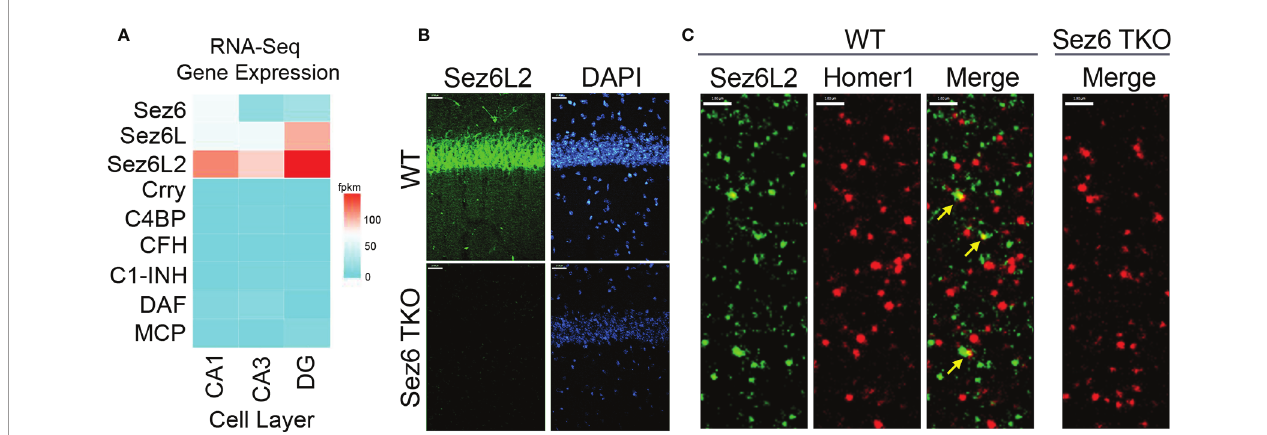
FIGURE 1 | Sez6 family expression in the hippocampus. (A) Sez6, Sez6L, and Sez6L2 are expressed by principal (excitatory, pyramidal) neurons of the mouse hippocampus at much higher levels than other known complement regulators (namely Crry, C4BP, CFH, C1-INH, DAF, and MCP). Expression data was obtained from Hipposeq: a comprehensive RNA-Seq database of gene expression in hippocampal principal neurons [http://hipposeq.janelia.org (60)]. The RNA samples used in this database were isolated from mouse hippocampal principal neurons micro-dissected from the CA1, CA3, or Dentate Gyrus (DG) cell layers of the hippocampus at Postnatal Day 25-32. Differential gene expression is shown in the heatmap with the relative units of FPKM (Fragments per Kilobase of Exon per Million Reads Mapped.) (B) Brain sections from adult WT mice or Sez6 triple knockout mice (TKO) were immuno-stained for Sez6L2 (green) and DAPI and imaged in the CA1 region of the hippocampus. Scale Bar= 27 µm. High density Sez6L2 staining occurs around cell bodies in the pyramidal layer, but signi fi cant Sez6L2 is also found in the stratum radiatum and stratum oriens. (C) Higher magni fi cation images of sections immuno-stained for Sez6L2 (green) and the postsynaptic protein, Homer1 (red), shows a subset of Sez6L2 is found near or co-localized with synapses in the stratum radiatum. Scale bar = 1.8